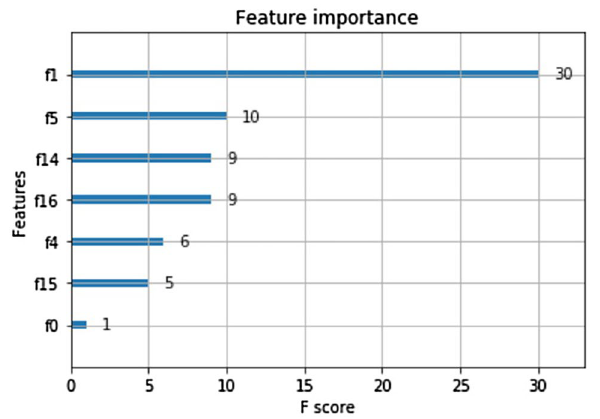
Figure 4. Features importance in XGBoost model. f1: age; f5: Dp; f14: HDL-C; f16: HCY; f4: Sp; f15: FPG; f0: